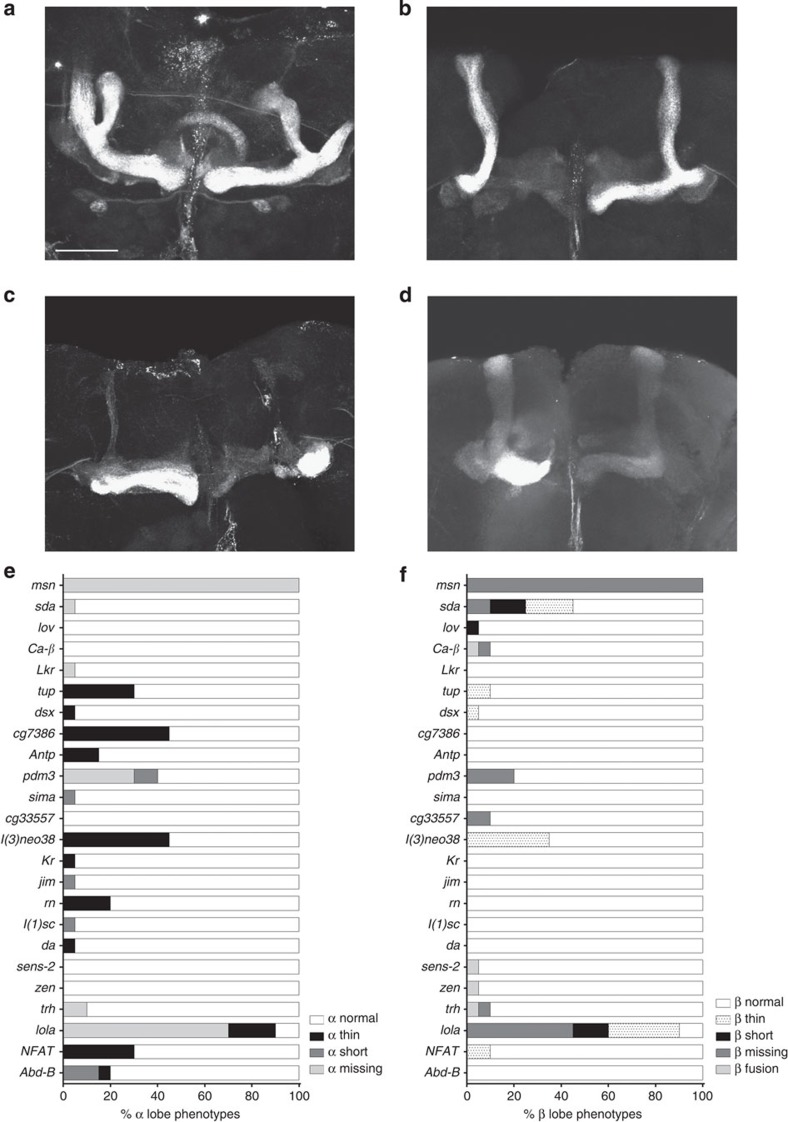
RNAi-mediated knockdown of the identified genes and transcription factors results in gross MB defects.(a–d) Anti-FasII staining visualizing the αβ lobes of the MBs in the adult brain of 3–7 day old males (scale bar, 50 μm) (a) UAS-RNAi-AbdBTRIP35647, OK107-Gal4 (b) UAS-RNAi-CG33557VDRC23517, OK107-Gal4 (c) UAS-RNAi-lolaTRIP35721, OK107-Gal4 (d) UAS-RNAi-sdaTRIP 37494, OK107-Gal4. (e,f) Quantification of variation in gross MB defects on RNAi-mediated knockdown (N=20 hemispheres). (e) α lobe defects. (f) β lobe defects.